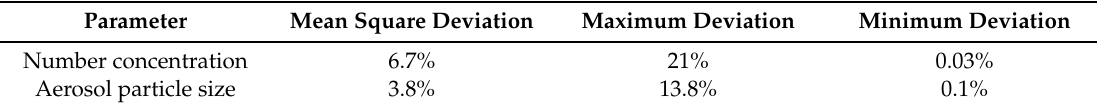
Table 2. The deviations of the measured results by aerosol sensor from reference